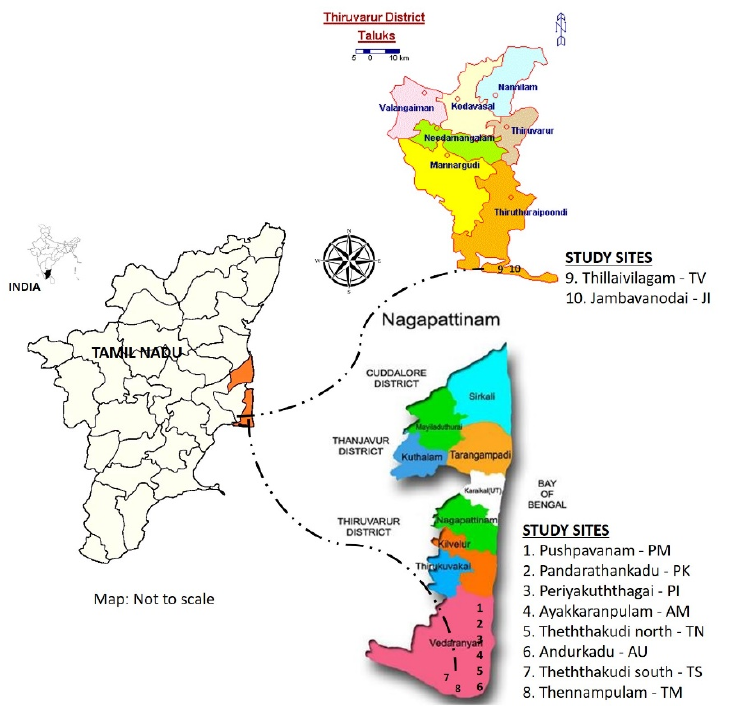
Figure 1. Map of study area showing locations of forest sites wherein leaf trait study was conducted.